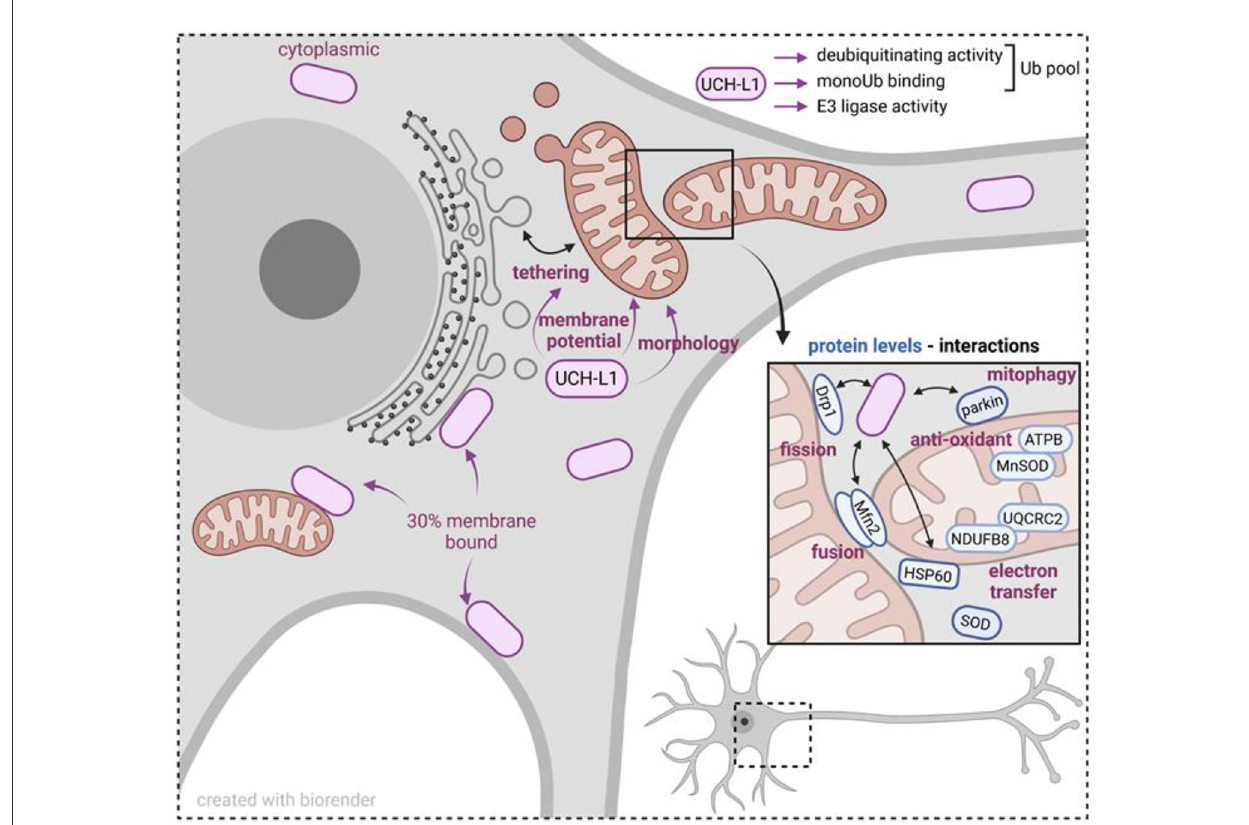
FIGURE1 Scheme summarizing mitochondrial proteins and mitochondrial functions influenced by UCH-L1. UCH-L1 is the most abundant deubiquitinating enzyme within neurons, predominantly in the cytoplasm, and 30% as a membrane bound protein. Biochemically, UCH-L1 regulates the cytoplasmic pool of mono ubiquitin (Ub) and exerts an E3 ligase activity. UCH-L1 localizes to the mitochondrial membrane and is associated with modifying mitochondrial-ER tethering, mitochondrial membrane potential and morphology. UCH-L1 impacts the abundance of mitochondrial cytoplasmic and matrix proteins and by this influences mitochondrial fusion and fission processes, electron transfer, and removal of defective mitochondria by mitophagy. In summary, UCH-L1 affects mitochondrial homeostasis and cellular energy